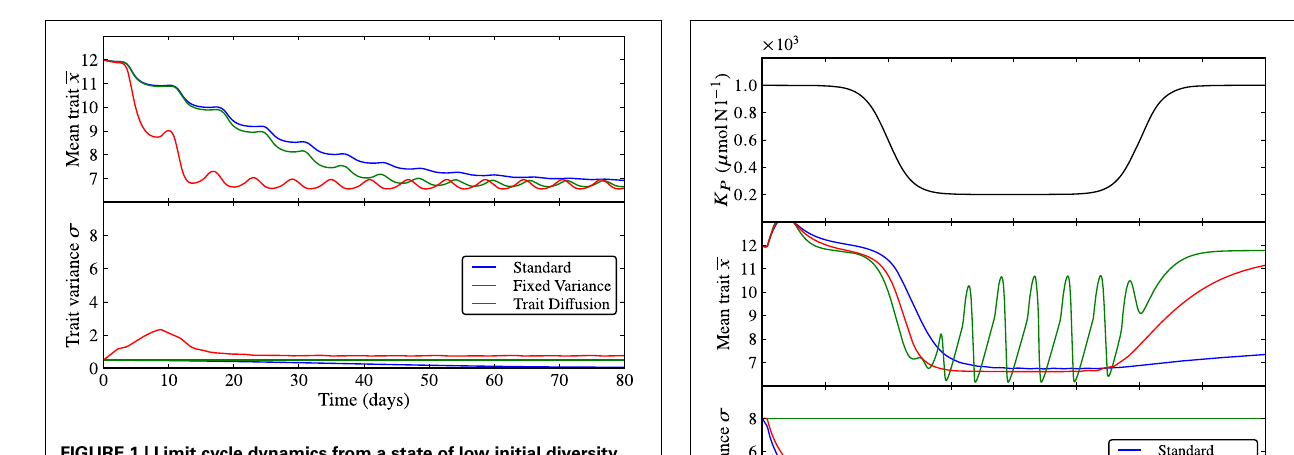
FIGURE 1 | Limit cycle dynamics from a state of low initial diversity ( σ (0) = 0 . 5). The trait variance converges to zero in the standard model (blue line), it is constant by construction in the model with fixed variance (green line), and it shows an initial increase followed by a relaxation to a steady-state with almost imperceptible superimposed oscillations under in the trait diffusion model (red line). The standard model clearly loses adaptive capacity in the long term (i.e., oscillations in the mean trait becomes weaker as the trait variance approaches zero). The corresponding NPZ dynamics is shown in Supplementary Figure 1.